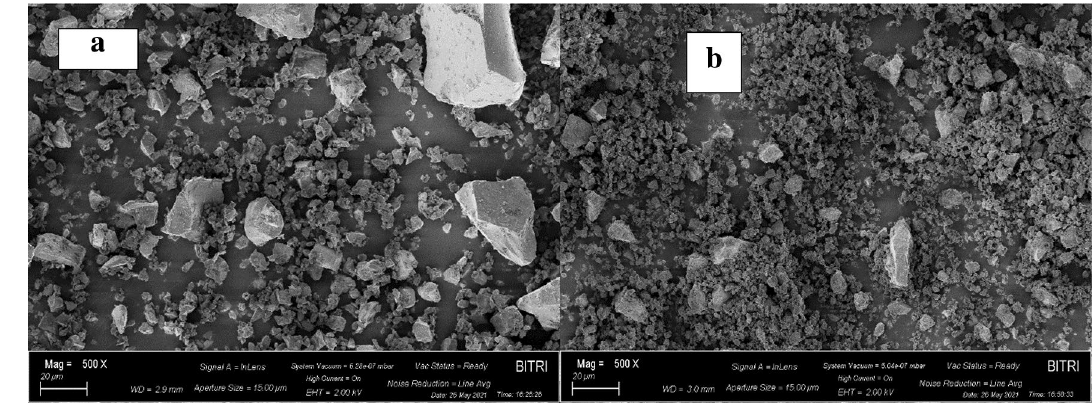
Fig. 1 Scanning electron microscopy for surface morphology before adsorption ( a ) and after adsorption ( b )